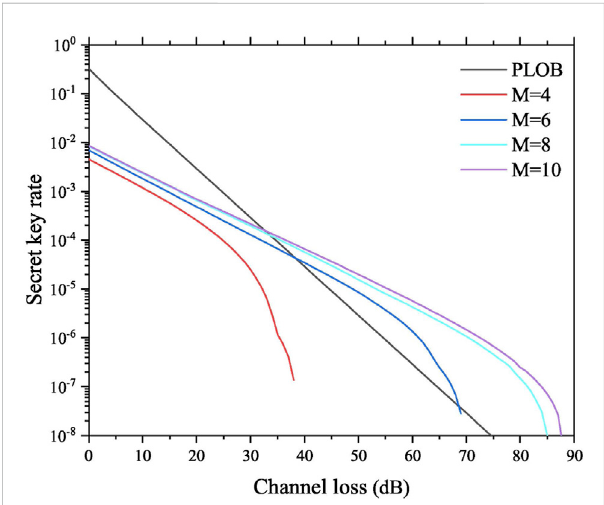
FIGURE 3 Results of the secret key rate versus channel loss for Protocol II withdifferent M values.TheblacklinerepresentsthePLOBbound,and thecurvesrepresentthesecretkeyratesofProtocolIIwith M =4,6,8, and 10.